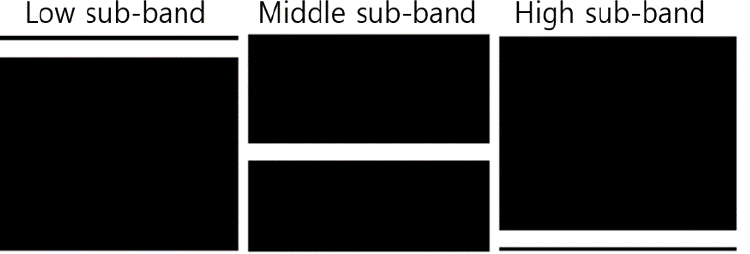
Figure 2. Three different data embedding regions in a frequency-domain image. The white re- gions represent the positions of the frequency sub-bands containing data. Low, middle, and high sub-bands indicate that the lower, middle, and higher frequency coefficients are used for data embedding,